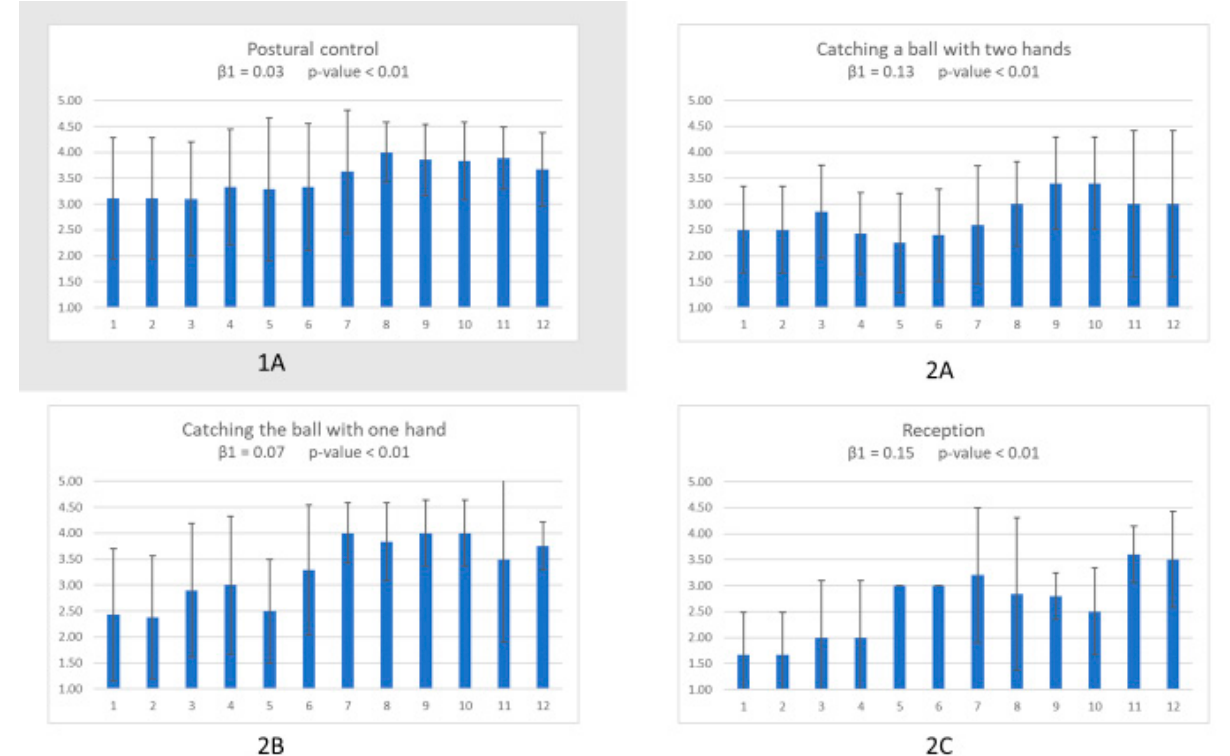
Figure 1. Fortnightly means and SD for postural control ( 1A ) and the three eye-motor variables: catching and throwing a ball with two hands ( 2A ), catching and throwing the ball with one single hand ( 2B ), and reception of different objects ( 2C ). Significant improvements were observed in all variables ( p < 0.01).